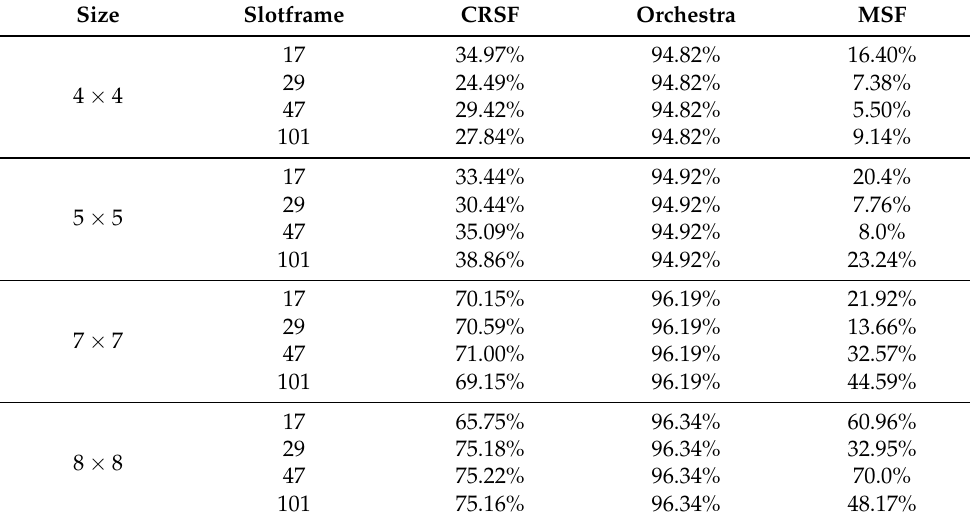
Table A3. Results for the Radio Duty Cycle (RDC) with a periodic traffic pattern.